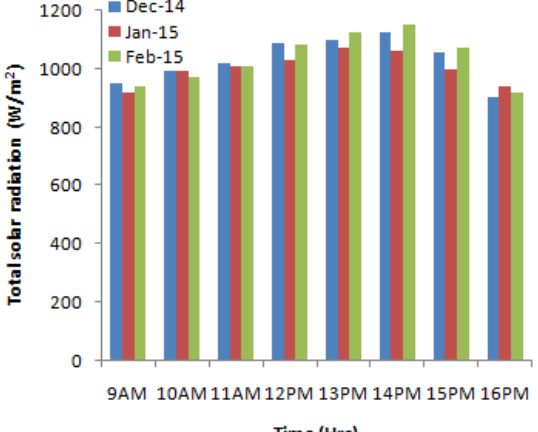
Figure 7. Average total solar radiation variation with time for three months